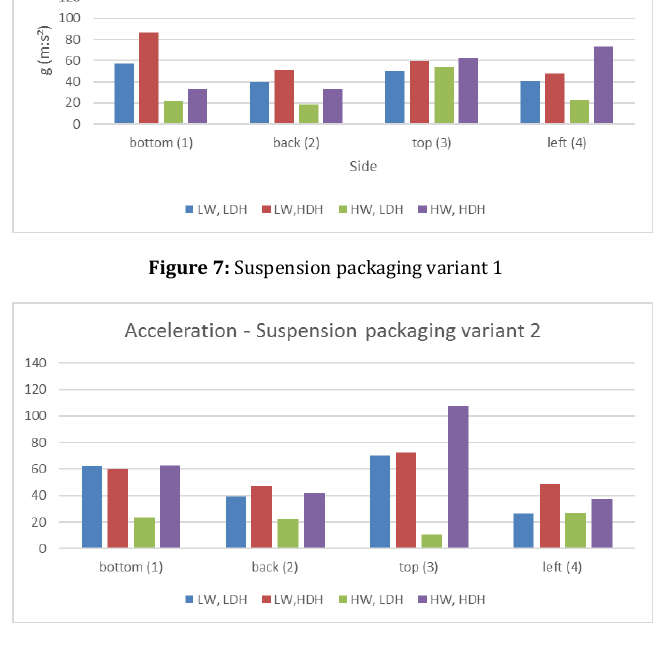
Figure 8: Suspension packaging variant 2